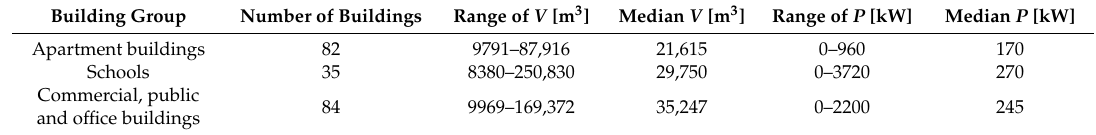
Table 1. Measurement data from January 2013 for 201 buildings in the city of Jyväskylä,